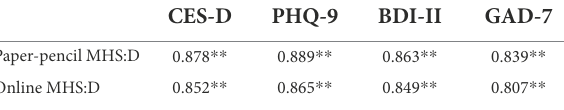
TABLE 3 Correlation coefficients between MHS:D and related measures.